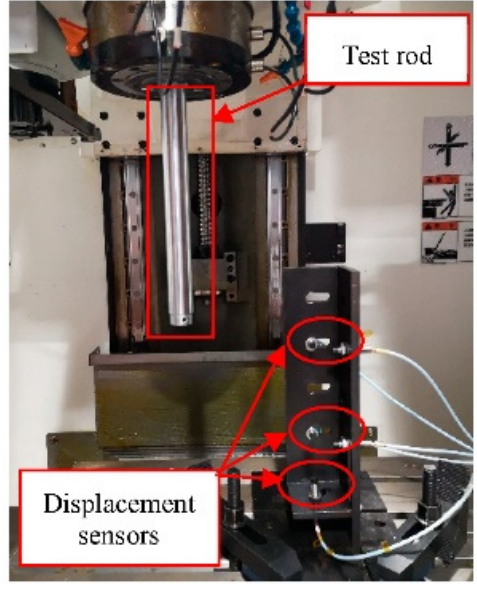
Figure 2. Distribution of displacement sensors.